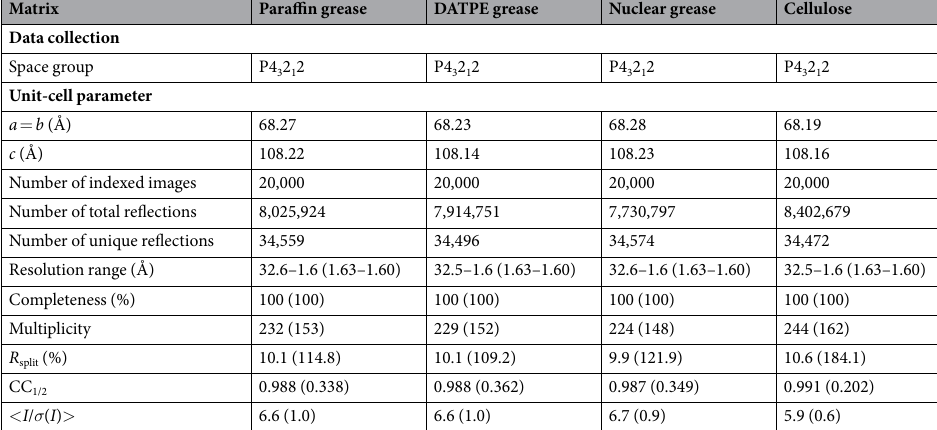
Matrix Paraffin grease DATPE grease Nuclear grease Cellulose